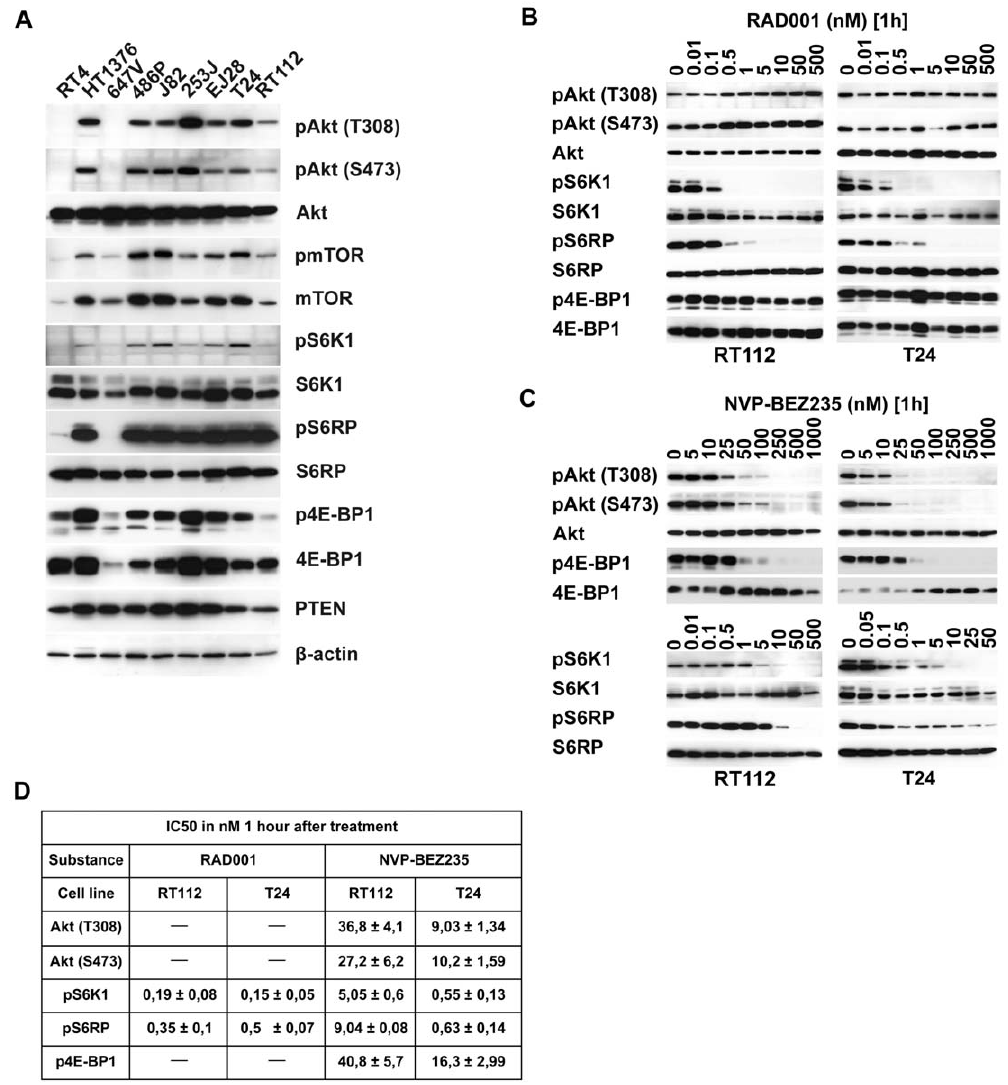
Figure 1. Activation status of the PI3K signaling pathway and cellular profiling of RAD001 and NVP-BEZ235. A: For protein analysis, cells were lysed in RIPA buffer applied to SDS-PAGE and transferred to PVDF membrane. Phosphorylation and expression status of proteins were analyzed in immunoblots. B, C: Cell lines were treated for 1 h with the indicated concentrations of RAD001 and NVP-BEZ235. The control (0) contained same concentrations of DMSO as in samples with chemical compounds. One representative result from 3 independent experiments is shown. D: The inhibitory concentration of 50% (IC50) was determined for target proteins of PI3K and mTORC1. Chemiluminescence signals were quantified using the ChemiDoc imaging system (BioRad Laboratories) and normalized to protein expression level. The average values from three or more independent experiments are shown.